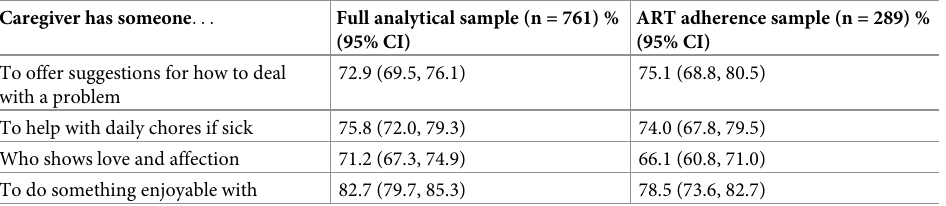
Table 3. Caregiver social